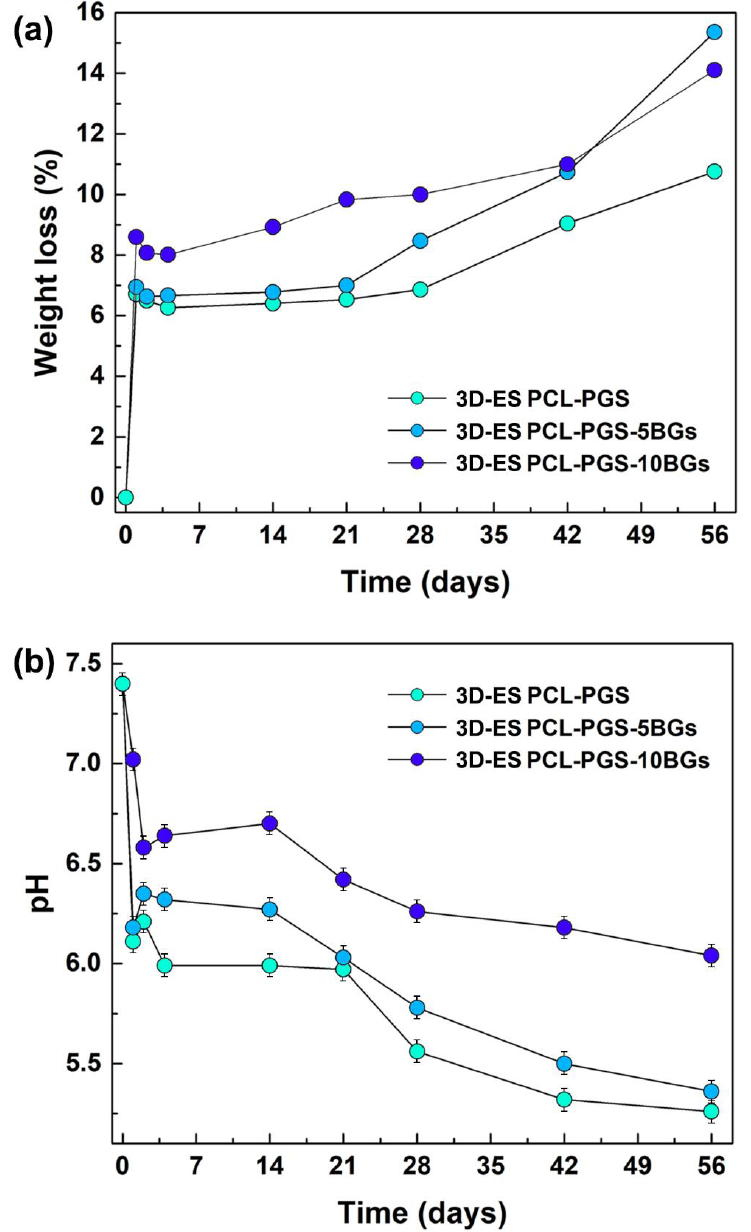
Figure 5. In vitro degradation of the composite scaffolds with and without bioactive glass microparticles: ( a ) percentage of weight loss and ( b ) pH changes at different timepoints. The data are represented as average ± standard deviation for five repeats (the size of the symbol includes the error bar).